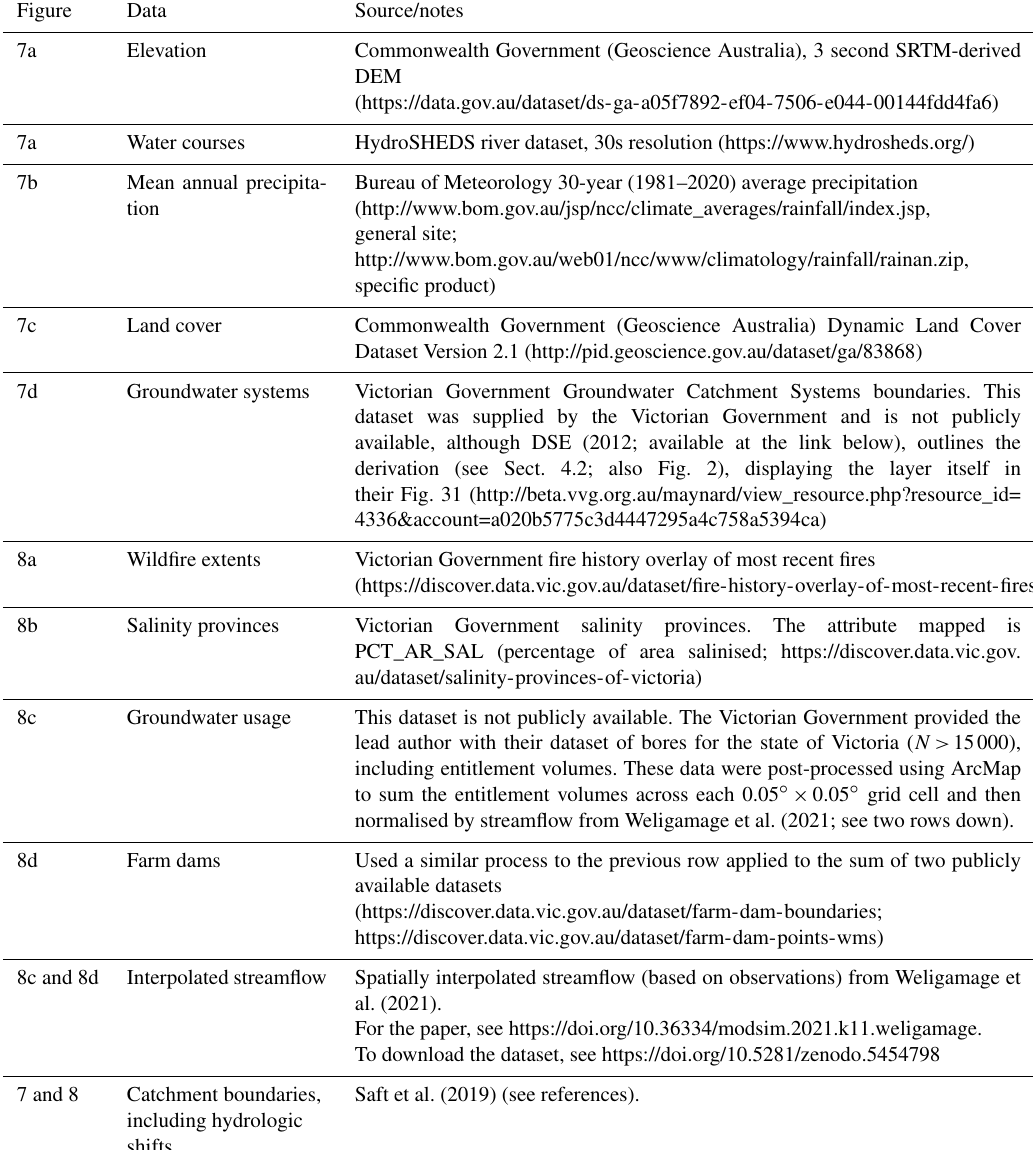
Table A1. Data sources and notes for Figs. 7 and 8. All URLs were last accessed 12 April